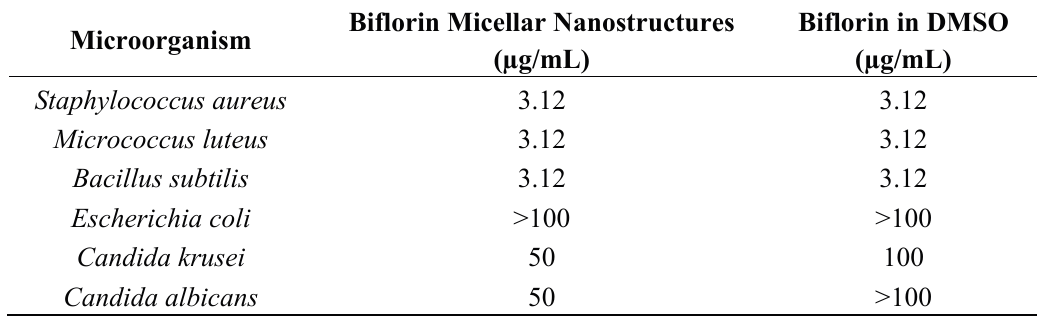
Table 2. MIC values for biflorin micellar nanostructures and biflorin dissolved in